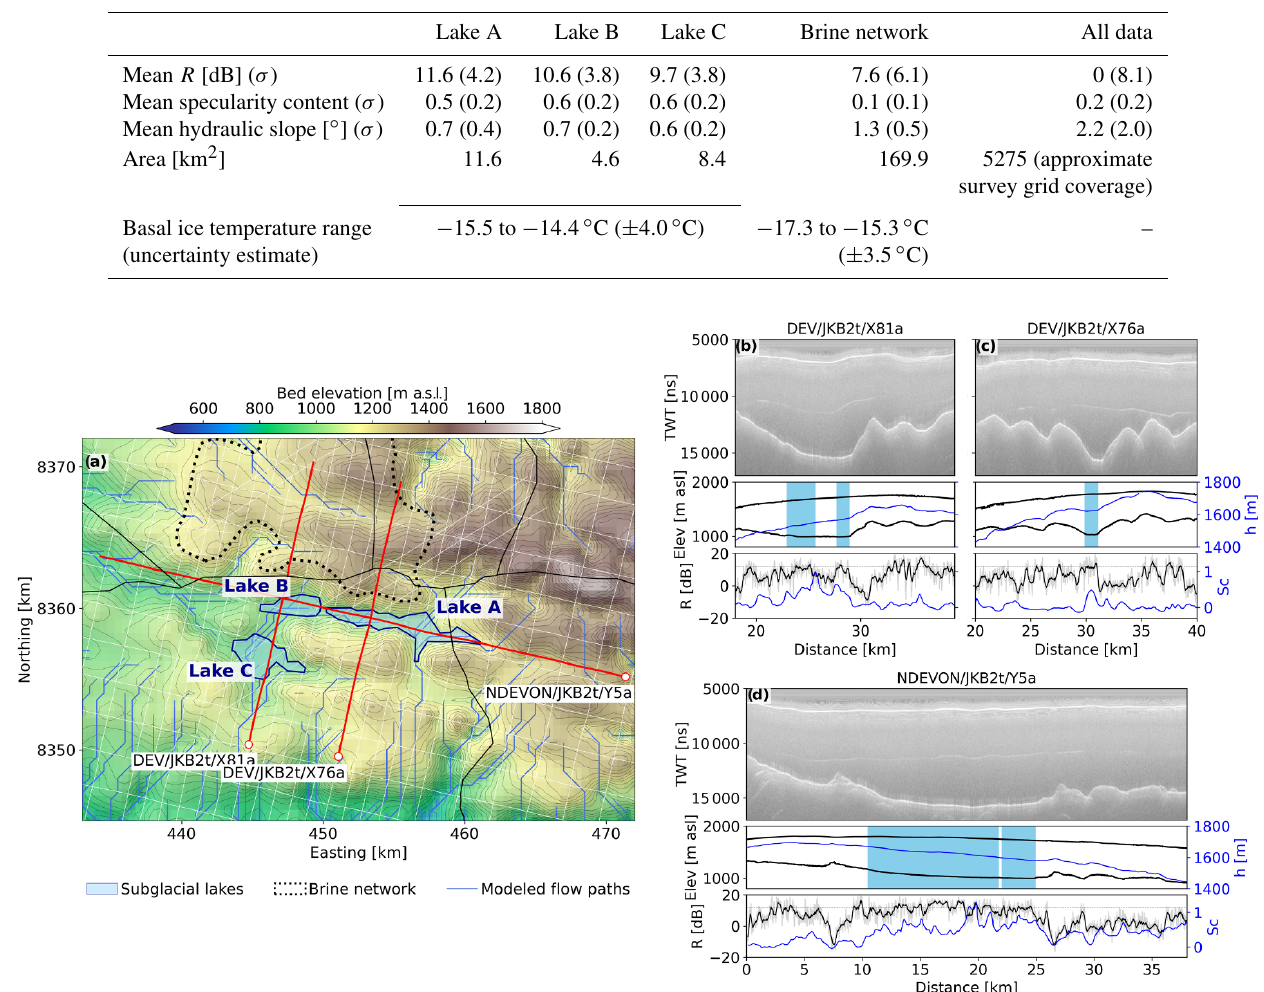
Figure 5. Geometry of subglacial lakes. (a) Subglacial bedrock topography overlain with the newly defined shorelines of subglacial lakes (blue shaded areas), interpreted outlines of the brine network (black dashed line), and modeled subglacial water flow paths (blue). White lines represent all SRH1 radar sounding survey profiles, whereas red lines mark the selected profiles shown in panels (b) – (d) , with the white dots marking the left side of the radargrams. (b–d) Example survey profiles over subglacial lakes (blue shaded) showing the radar data (top), the surface and bedrock elevation along with the hydraulic head h (middle), and the reflectivity R and specularity content Sc